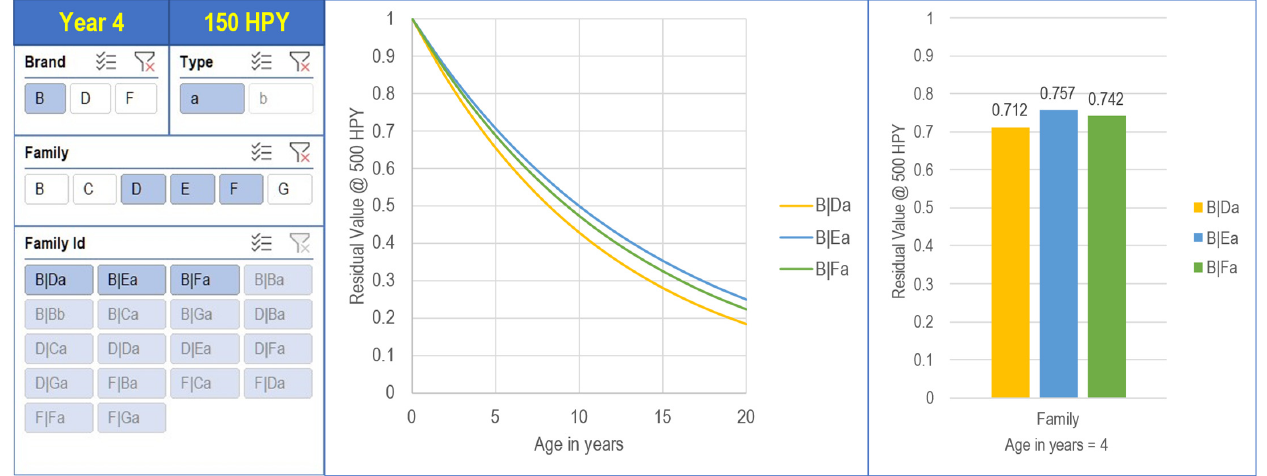
Figure 10. Residual value (value as new = 1) comparison of Brand B combine families with 150 h per year (HPY).